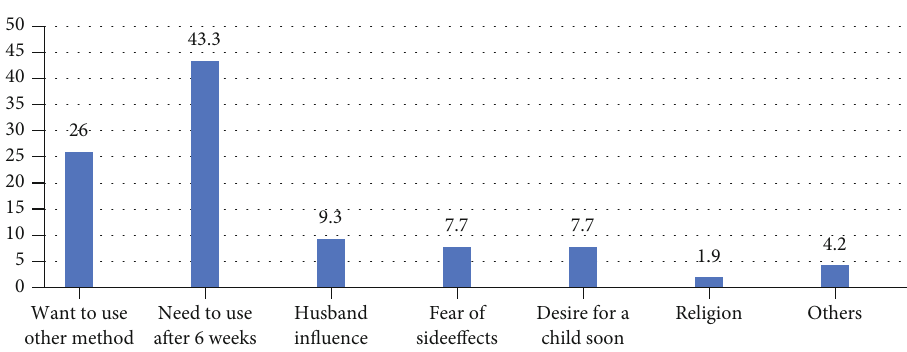
Figure 1: Reasons for not to use postpartum LARCs in HUCSH,